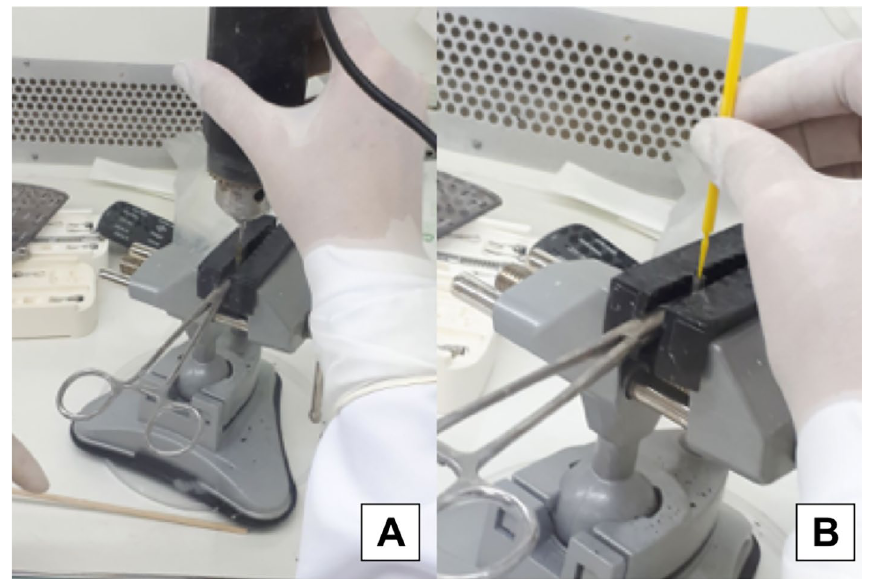
Figure 6. ( A ) Detorque of the abutment-implant set with the digital torque wrench; ( B ) Sample collection from the inner side of the implant after